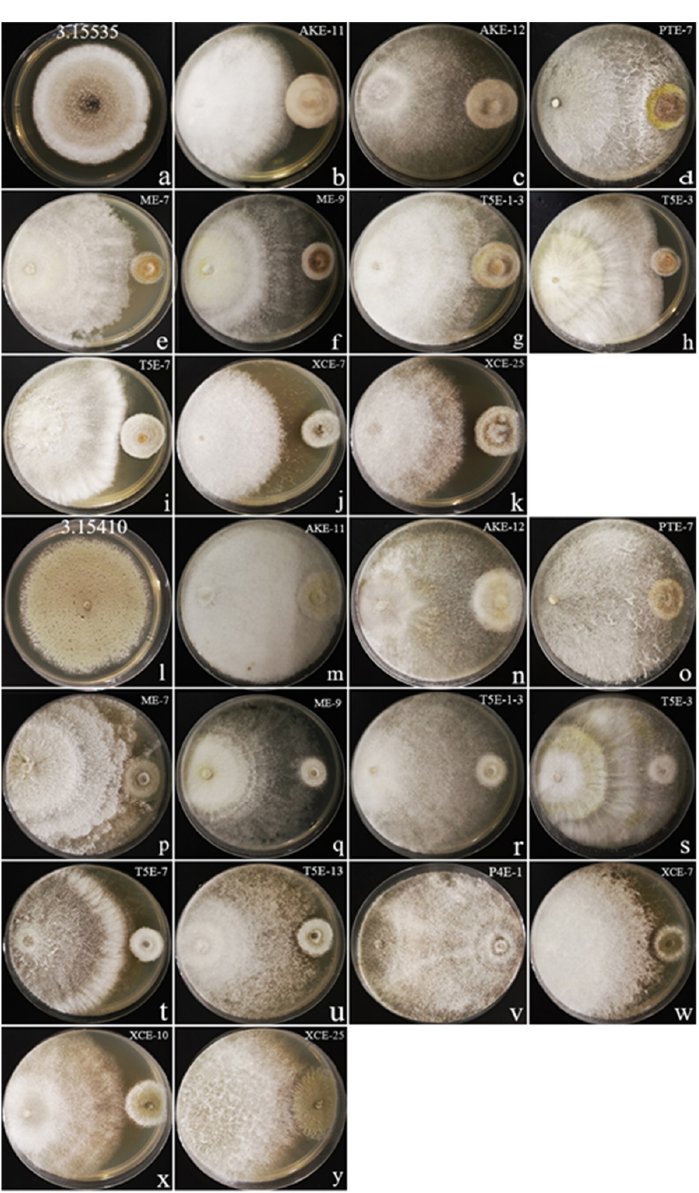
Figure 6. Illustration of an antagonist test using the dual-culture technique with two fungal pathogens and an inhibition rate greater than or equal to 60%. The two pathogens were cocultivated with the coffee fungal endophytes on PDA plates and incubated for ten days at 28 °C. ( a ) Alternaria alternata control plate; ( b – k ) Coffee endophytes inhibit A. alternata ; ( l ) Penicillium digitatum control plate; ( m – y ) Coffee endophytes inhibit Pen. digitatum .